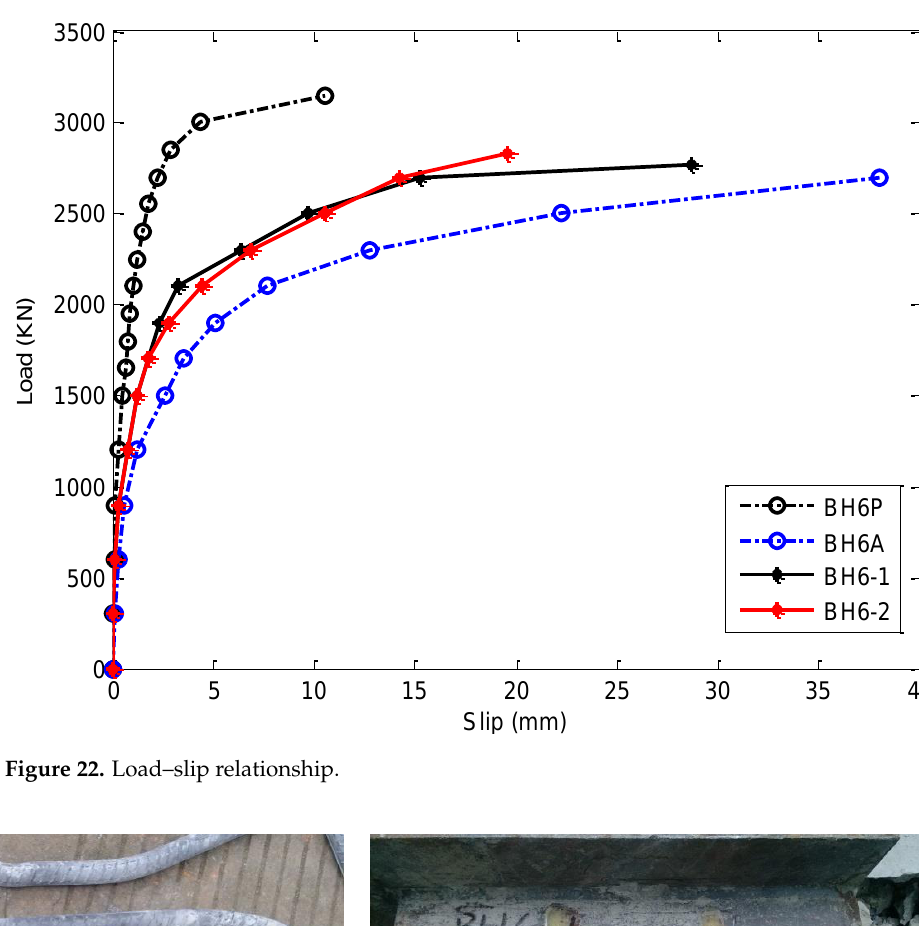
Figure 22. Load – slip relationship. Figure 22. Load–slip relationship.